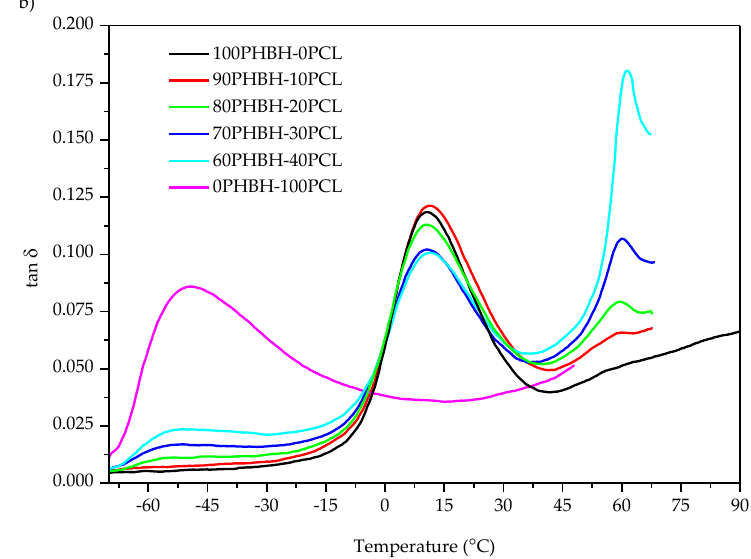
Figure 3. Comparative plot of the dynamic mechanical thermal analysis (DMTA) properties of PHBH, PCL, and PHBH/PCL blends with different PCL wt %, as a function of temperature, ( a ) storage modulus, E’ , and ( b ) dynamic damping factor (tan δ).